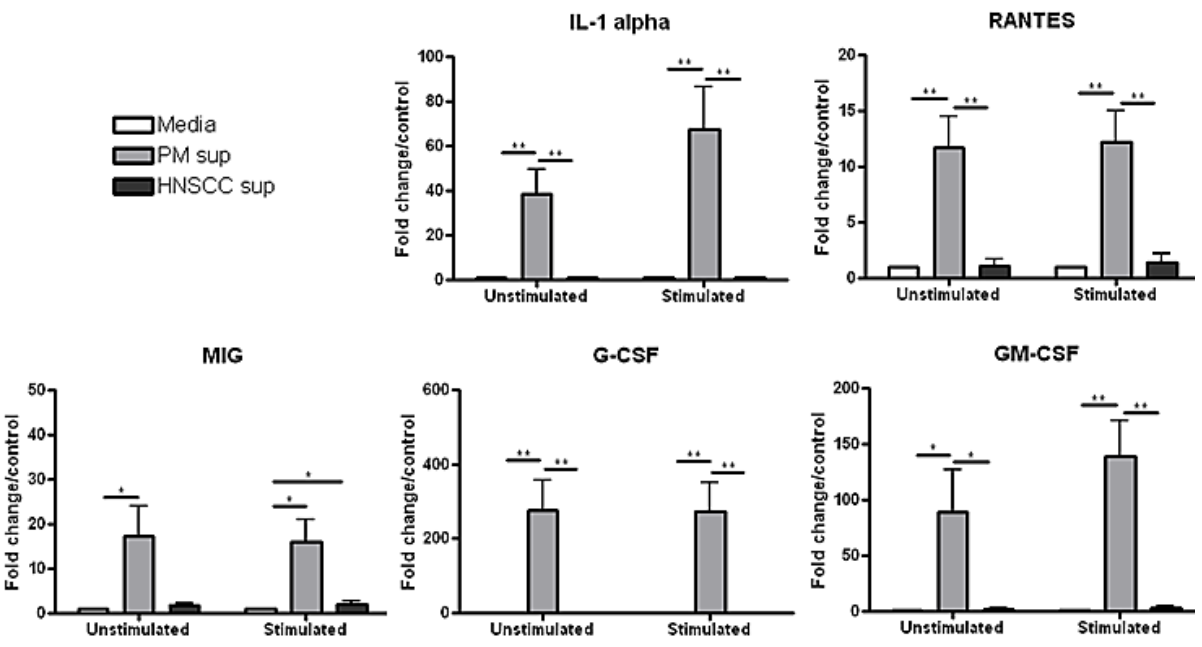
Figure 2. Splenocytes cultured with premalignant supernatant release significantly increased levels of innate proinflammatory mediators compared to splenocytes cultured with HNSCC supernatant or media alone. Splenocytes were incubated with media, premalignant cell-conditioned supernatant, or HNSCC cell-conditioned supernatant, respectively, and supernatant was collected for cytokine/chemokine analysis after 72 h. Data shown represent 3 independent experiments performed in duplicate. * p < 0.05 ** p <